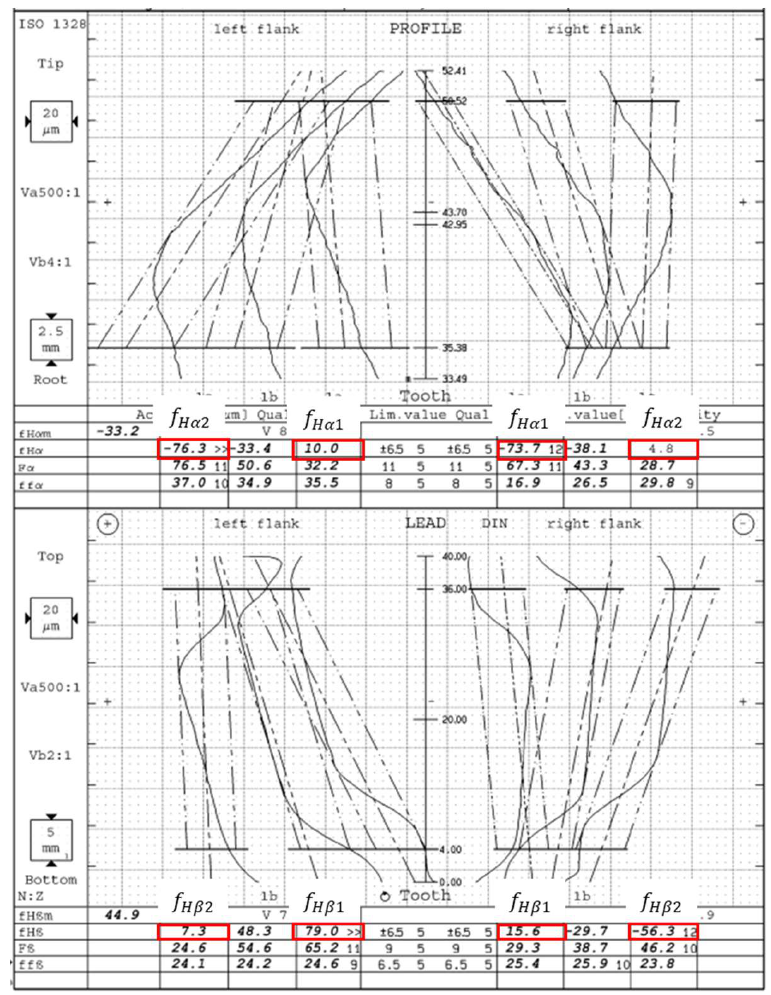
Figure 6. Measurement results of gear measuring center P26.